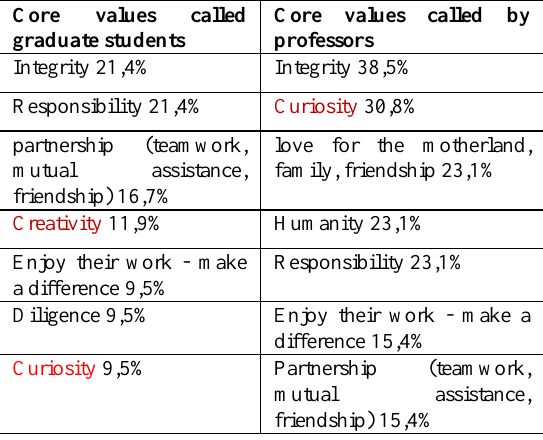
Table 2. Basic human qualities of an engineer through the eyes of